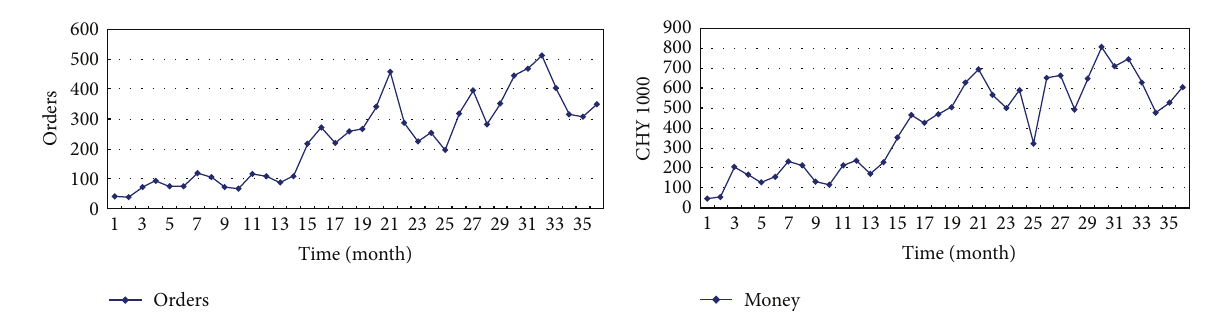
Figure 3: Irregular orders and money per month in total.